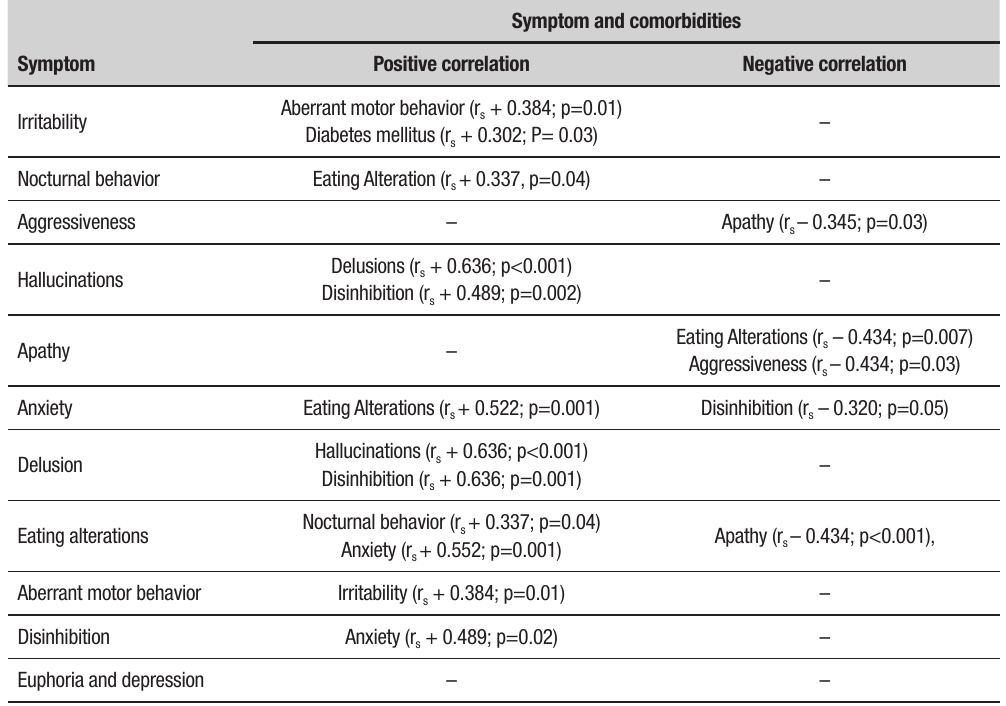
Table 3. Correlation between symptoms and symptoms, as well as between symptoms and